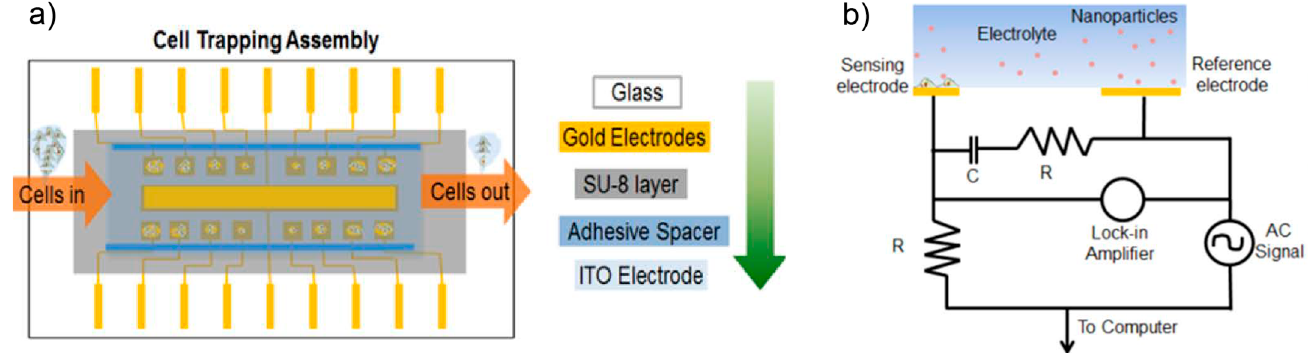
Figure 3. Cells-on-chip assembly. ( a ) Microelectromechanical system assembly for the dielectrophoretic trapping of cells; glass wafer is the base, gold sensing electrodes are under the SU-8 microwell pattern, spacer is used to hold the top ITO electrode. ( b ) Electronic cell impedance sensing circuit representing a single sensing electrode for simplicity. Reproduced with permission from [83]. Copyright 2016 American Chemical Society.